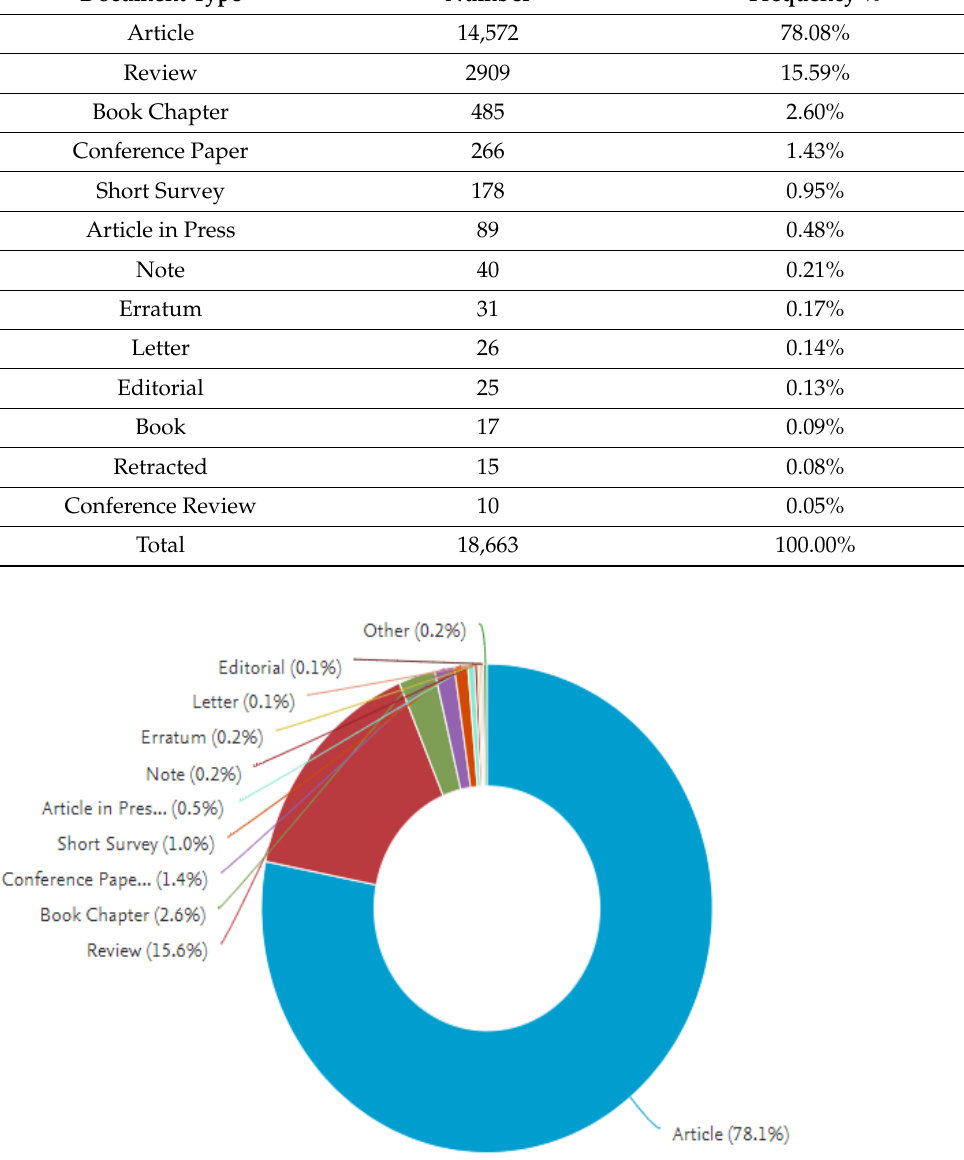
Figure 1. Document types of retrieved articles on miRNA in cancer (2003–2019). Table 2. Top 10 languages of retrieved articles on miRNA in cancer (2003–2019).